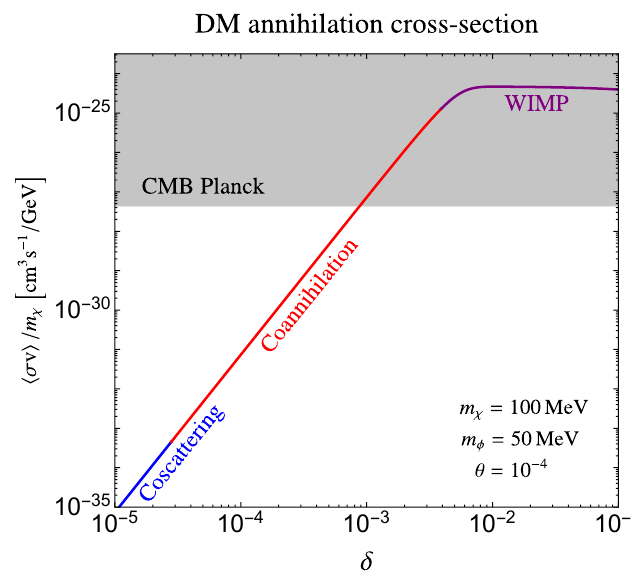
Figure 3 . The DM self-annihilation cross section, (cid:31)(cid:31) ! (cid:30)(cid:30) , as a function of the mass mixing between mostly sterile DM, (cid:31) , and an active state with rapid annihilations, . The amount of mixing is measured using the parameter (cid:14) (cid:17) (cid:14)m=m (cid:31) , where (cid:14)m is the mass mixing between (cid:31) and . The DM mass is (cid:12)xed to m (cid:31) = 100 MeV. DM annihilates to a scalar, (cid:30) , with mass m (cid:30) = 50 MeV and mixing angle (cid:18) = 10 (cid:0) 4 with the SM Higgs. (See section 2.2 and 3.1 for a detailed description of the model and de(cid:12)nitions of these parameters.) The color of the line delineates whether freeze-out is described by the WIMP (purple), coannihilation (red), or coscattering [15] (blue) phase. The gray region shows the Planck bound on DM annihilations [64], which excludes the WIMP phase for this DM